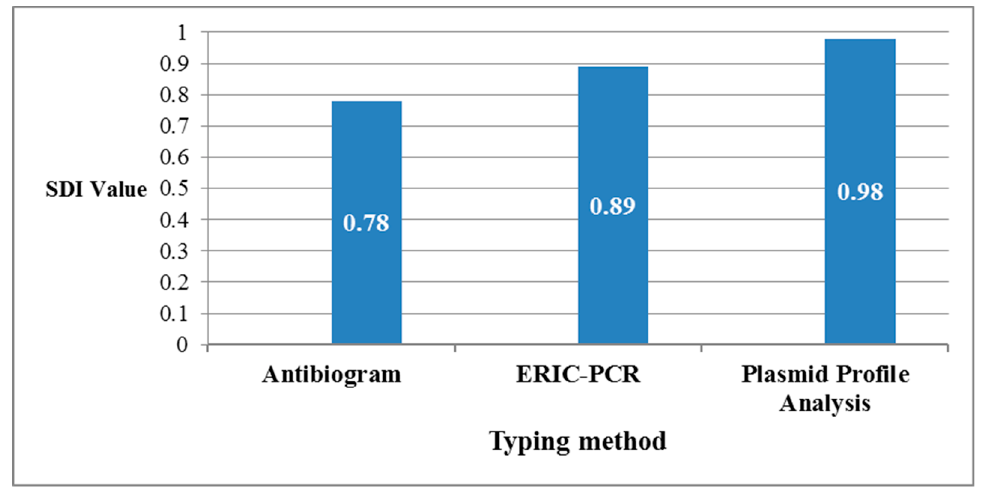
Figure 5. A comparative graph of calculated Simpson’s Diversity Index (SDI) of the applied typing methods to study the relatedness among the 34 K. pneumoniae isolates harboring bla OXA-48-like genes. SDI values were convergent as they were 0.78, 0.89, and 0.98 for antibiogram, ERIC-PCR, and plasmid profile analysis, respectively.